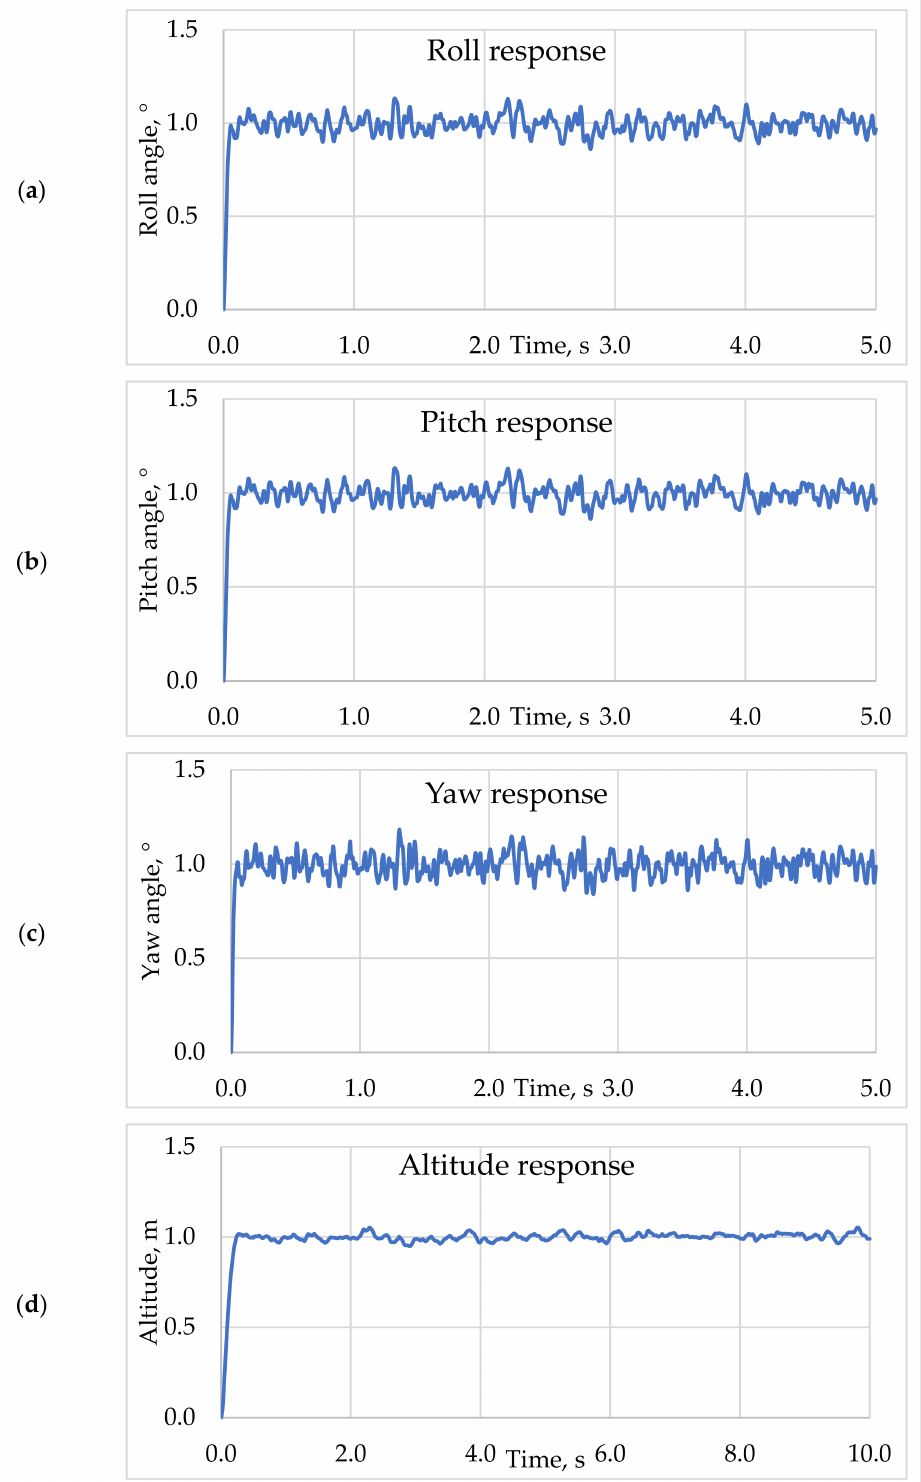
Figure 9. The step response of the system in the presence of sensor noise, ( a ) roll, ( b ) pitch, ( c ) yaw, and ( d ) altitude